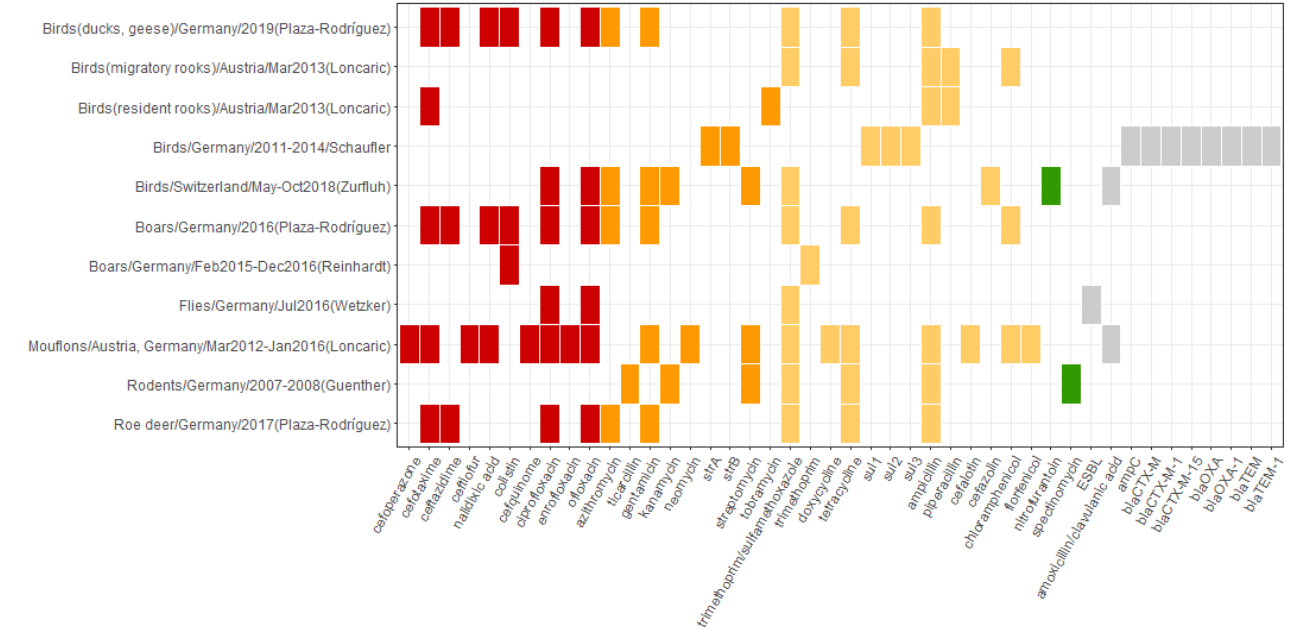
Figure 6. Overview of the occurrence of reported antibiotic resistance patterns in wildlife. The horizontal axis depicts resistance patterns as reported in the primary studies and includes antibiotic compounds, antibiotic classes, resistance mechanisms, and ARGs. The vertical axis represents the source of resistance associated with resistance patterns depicted on the horizontal axis as follows: source of sample/Country of study/Sampling period/(First author of the reporting study). The color profile represents the WHO CIA list categories: red, Critically important: Highest Priority; orange, Critically important: High Priority; yellow, Highly important; green, Important; grey, not listed.